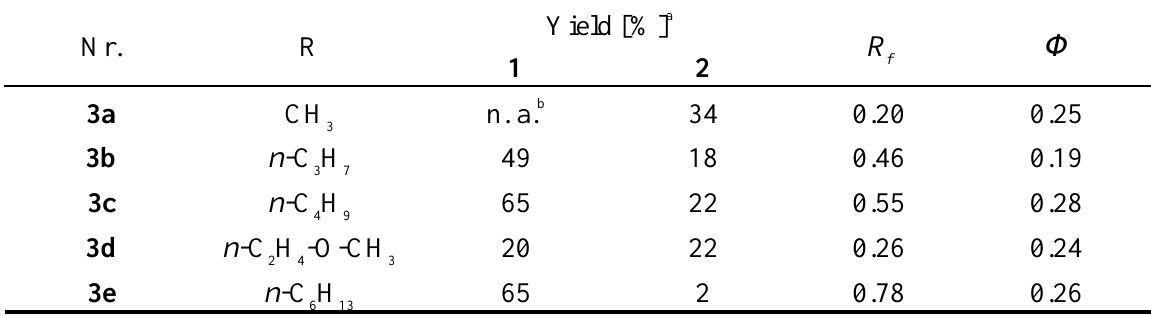
Table 1. Yield, R -Values and Quantum Yield of Fluorescence f